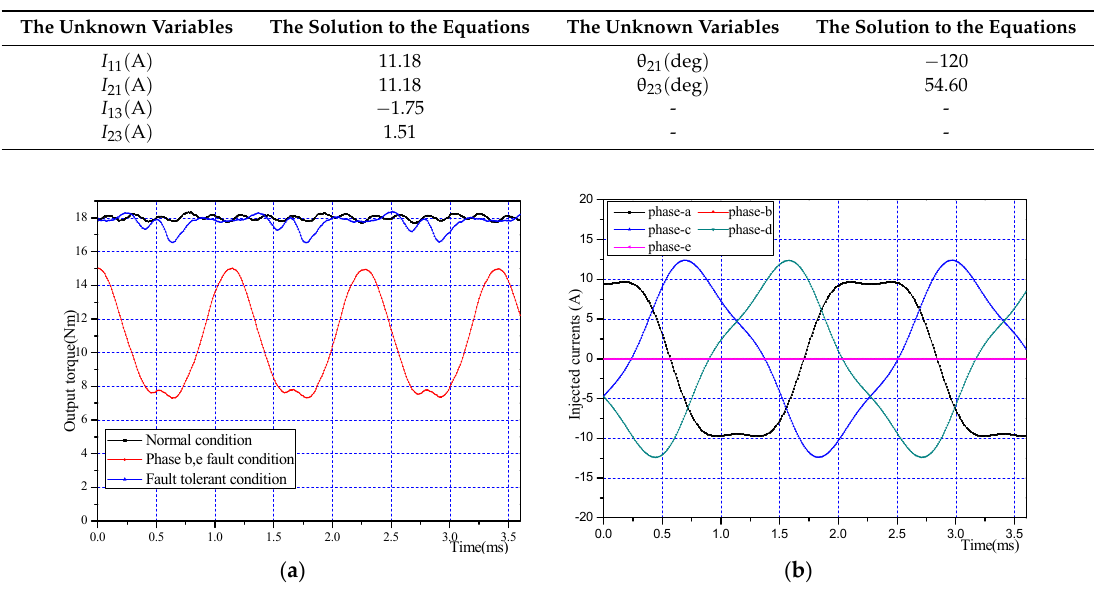
Table 2. The optimum solutions to the fault-tolerant currents under non-adjacent double-phase open-circuit fault types.